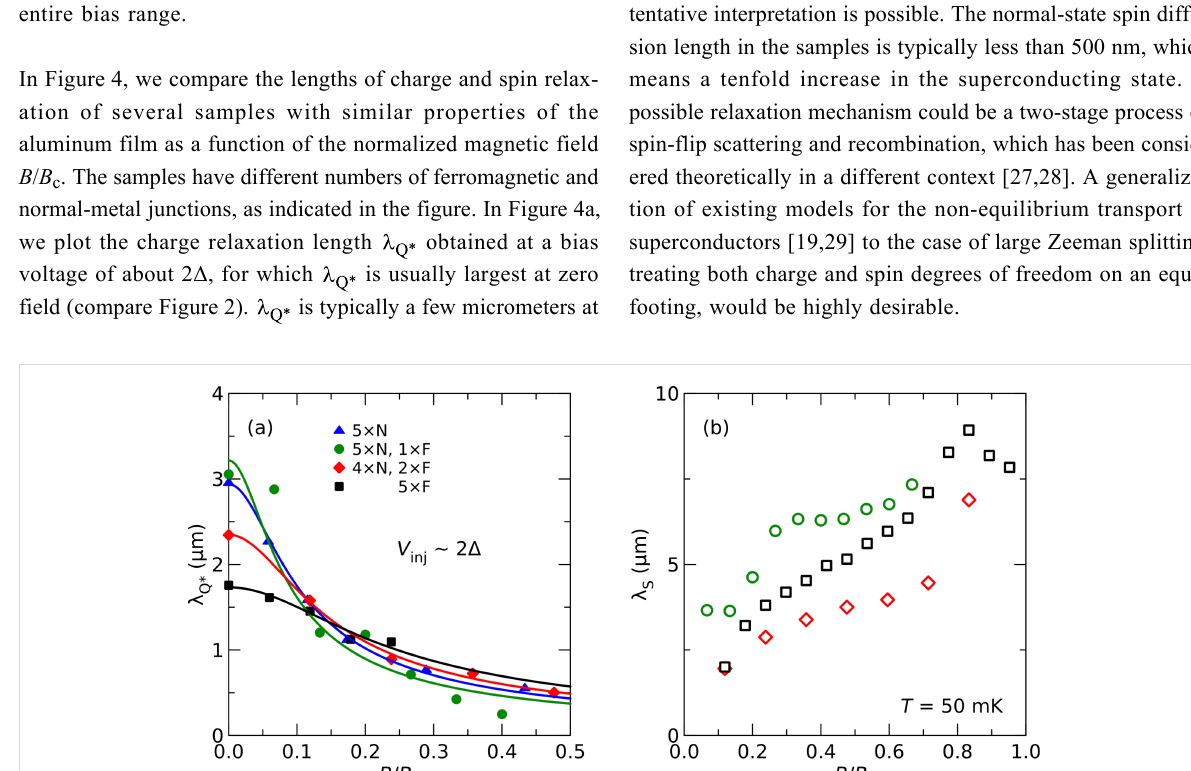
difference g ↓ − g ↑ . The lines in Figure 3b are the sum of the charge-imbalance contribution shown in Figure 3a and an addi- tional contribution to account for the spin signal. For the latter, we use parameters that we obtained from fits of the local conductance of the injector junctions, which leaves only the overall signal amplitude as a free fit